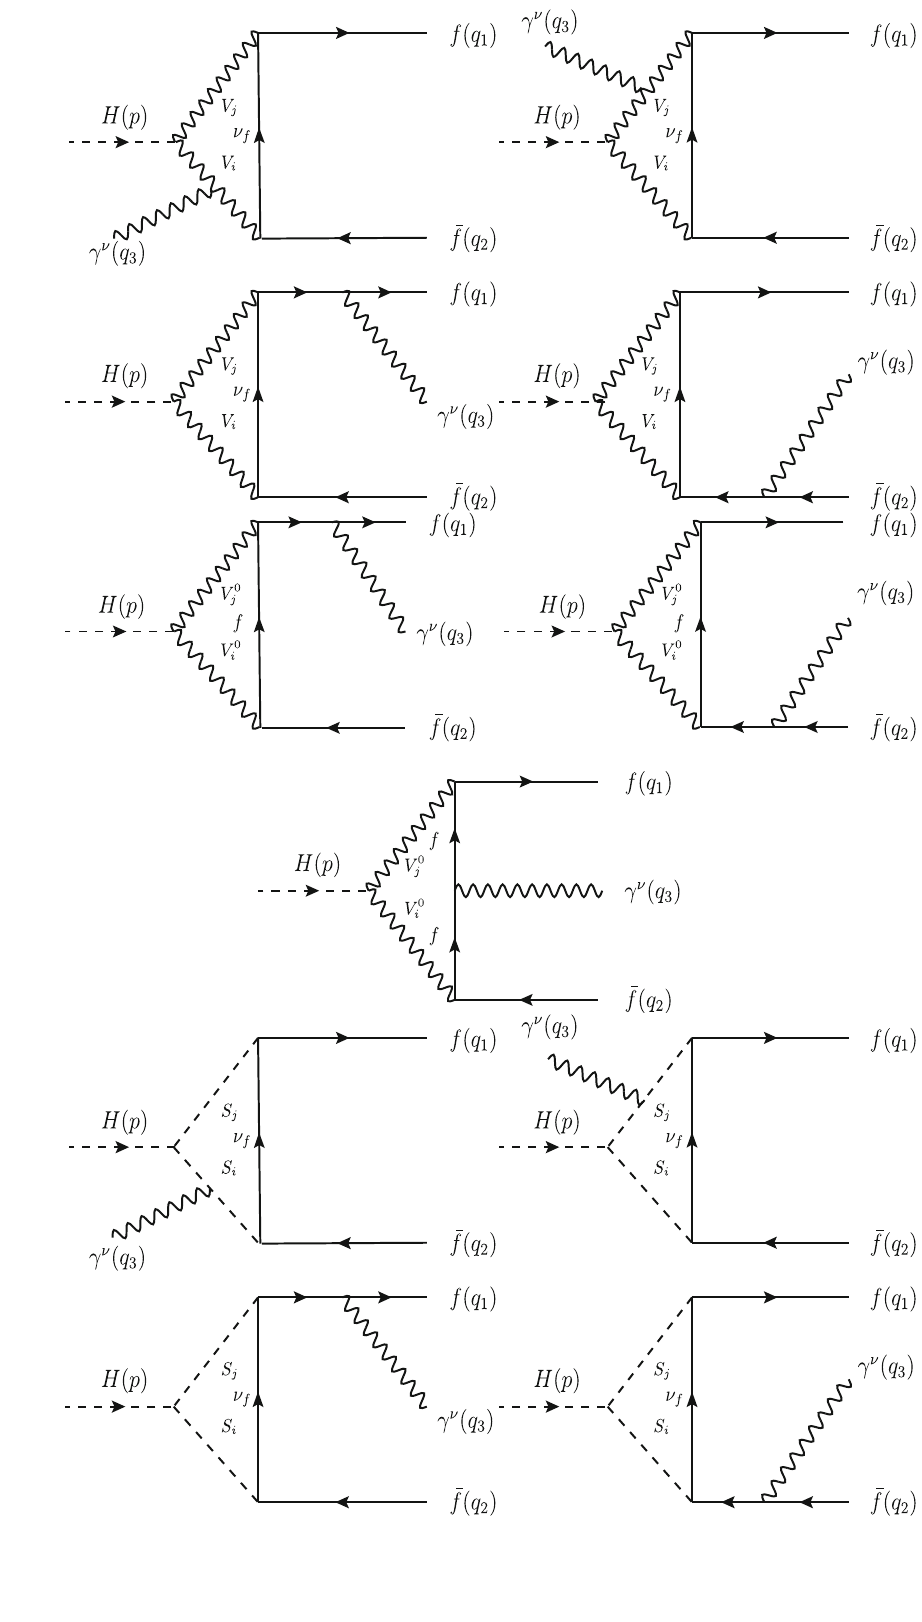
Fig. 7 One-loop triangle and box diagrams with vector bosons V i , j in the loop